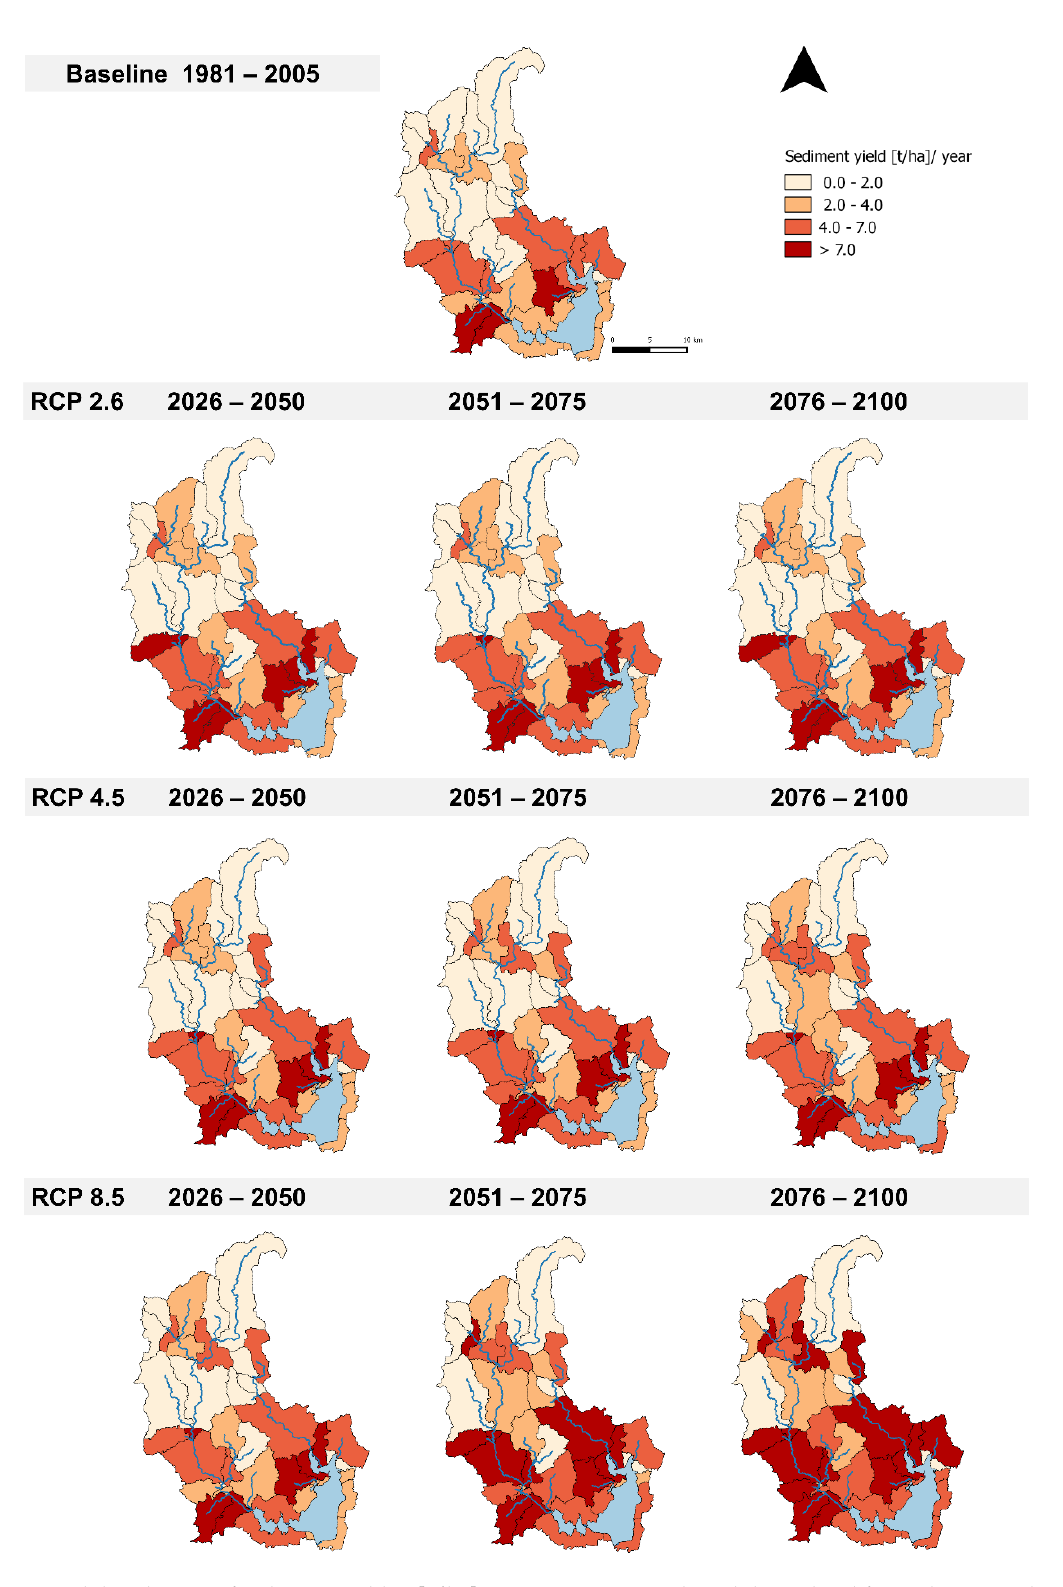
Figure 6. Spatial distribution of sediment yield in [t/ha] per-year metrics at the sub-basin level for each RCP pathway and time scenario.